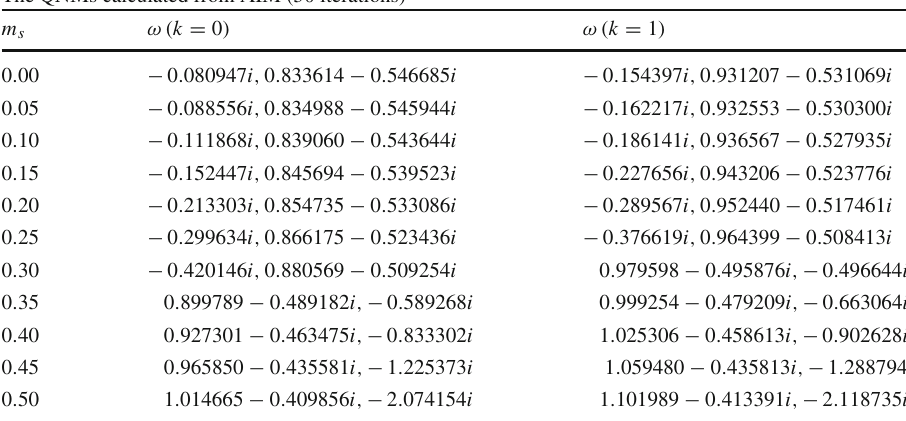
The QNMs calculated from AIM (50 iterations) m s ω ( k = 0